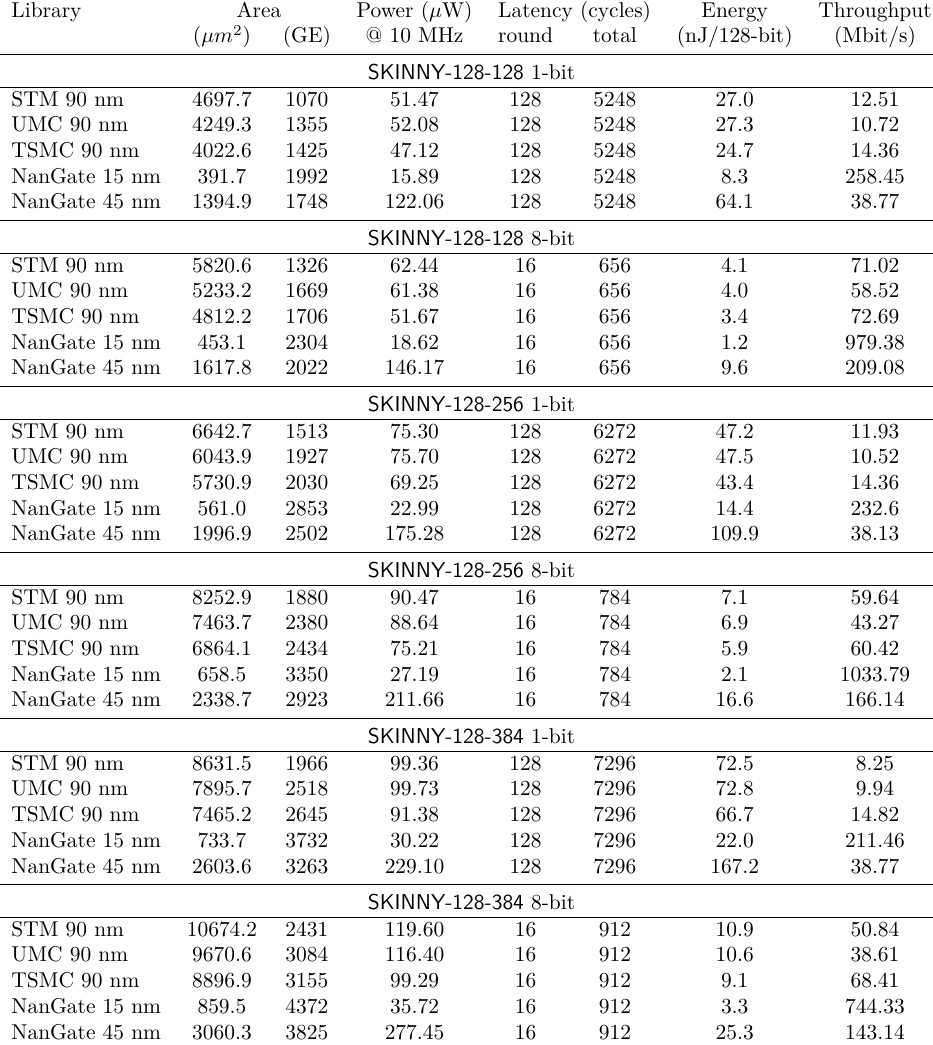
Table 8: Synthesis figures for the SKINNY encryption-only